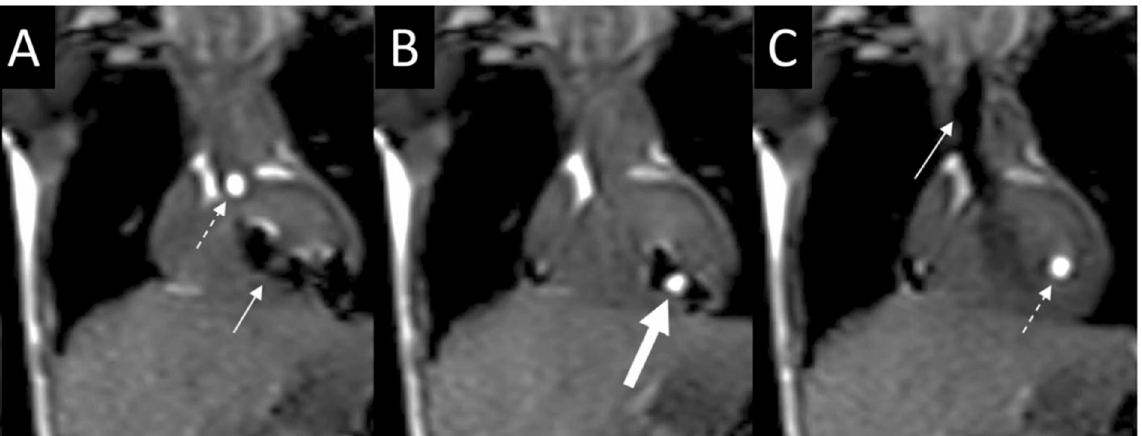
Figure 23. Series of images ( A – C ) in the coronal plane demonstrating step by step entrance into the left ventricle (LV) for pressure measurements using a gadolinium-filled balloon-tip catheter (dashed arrow) and the MR conditional guidewire (solid arrow). The thick solid white arrow is pointing to both the catheter and wire together within the LV. Revised from ref [16].